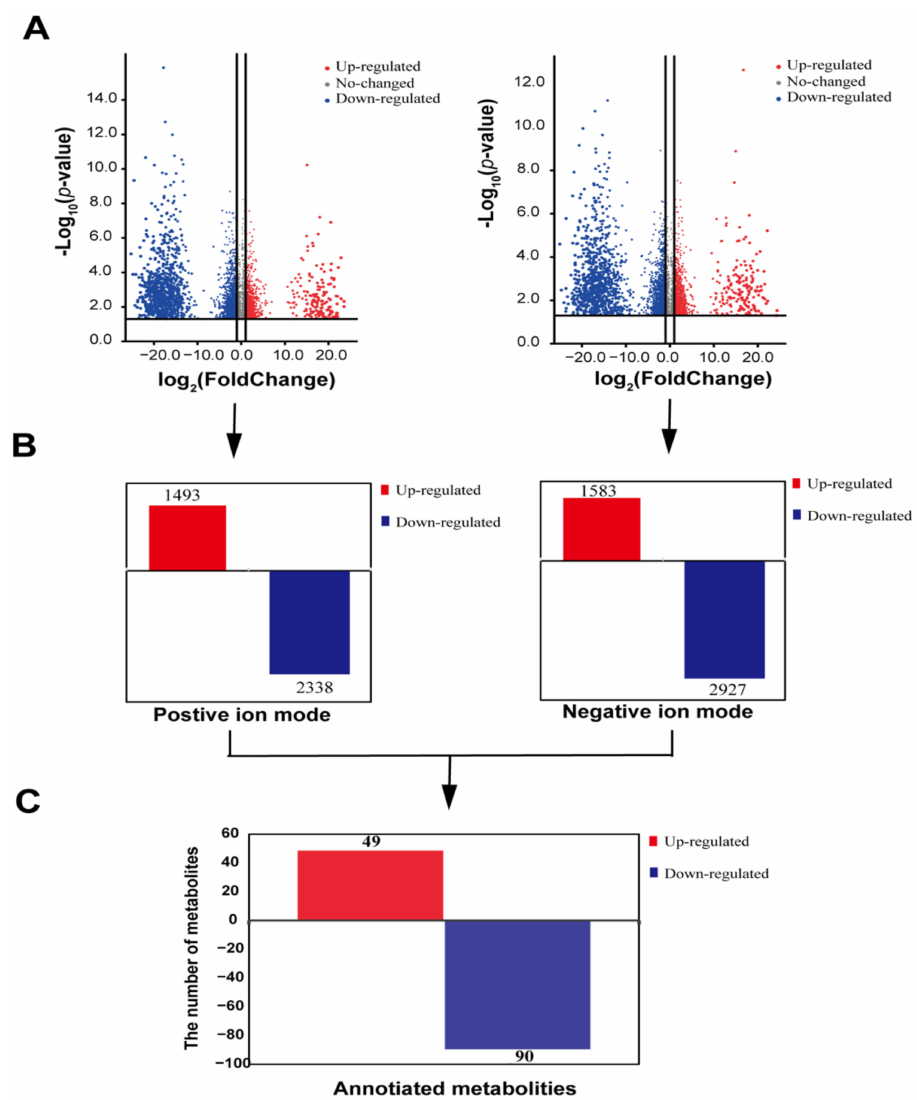
Figure 3. The enrichment and function annotation of differential metabolites between the sexes: ( A ) the volcanic map was used to show the whole of the differential metabolites in positive and nega- tive ion modes; ( B ) annotated histogram of differential metabolite statistics. The red block represents the up-regulated metabolites, and the blue block represents the down-regulated metabolites; ( C ) the histogram was to show the differential annotated metabolites between